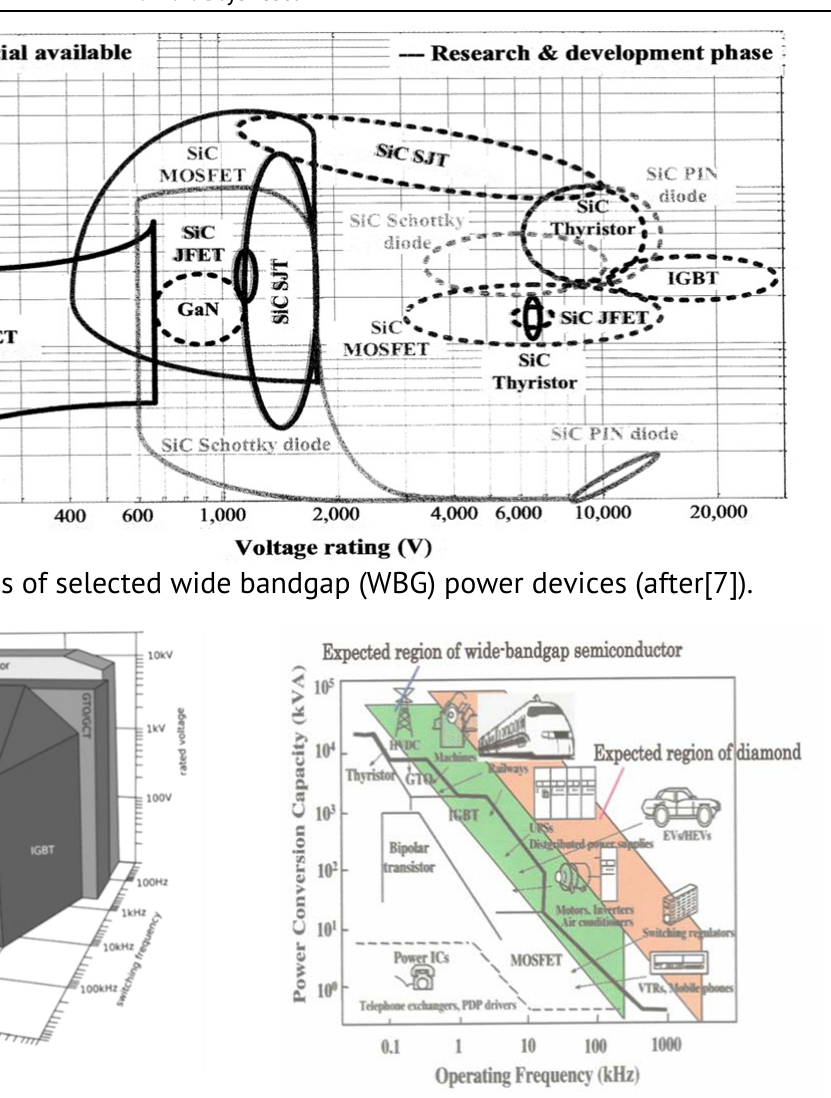
Figure 3. Operating range of silicon power semiconductor devices (after [1]).